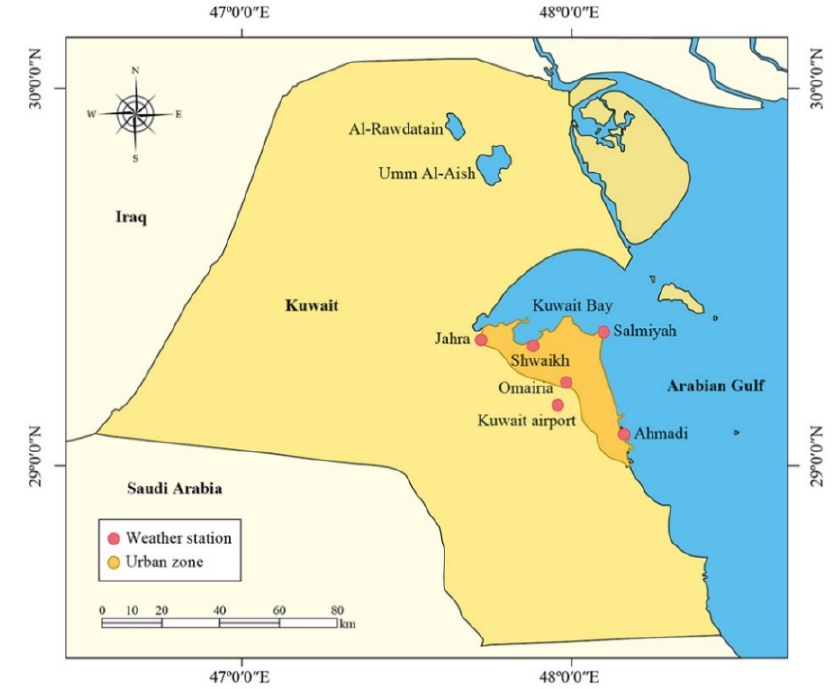
Figure 1. Locations of urban areas, weather stations, and major groundwater aquifers in Kuwait.